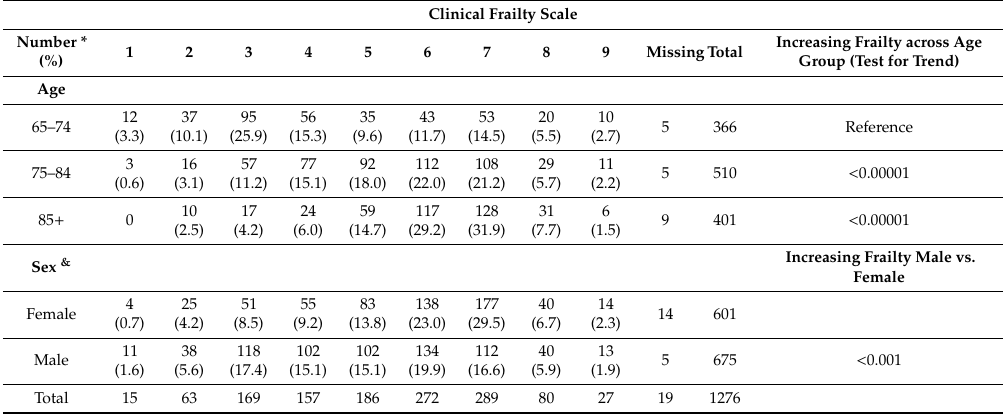
Table 2. Prevalence of Clinical Frailty Scale by Age Group and Sex in 1277 older patients admitted to 13 hospitals in COPE